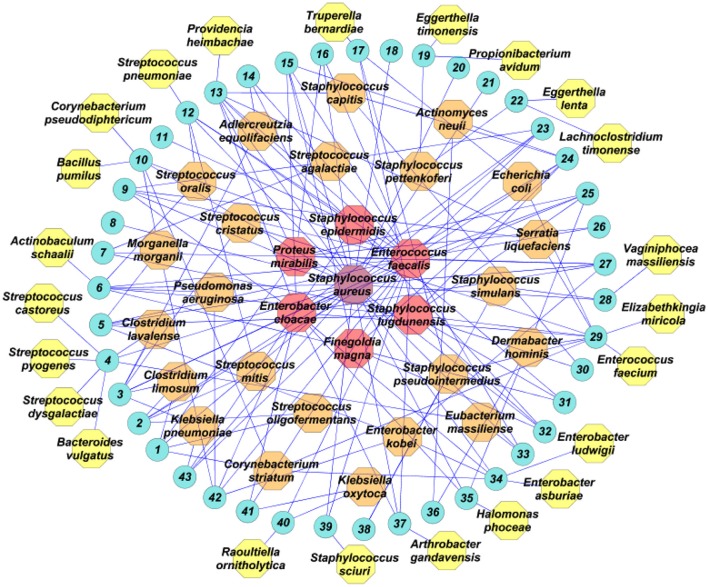
Bacterial species isolated from wound samples from 43 patients (blue circles), analyzed using culturomics. In purple, the most prevalent bacterial species; in red, the bacterial species isolated in five or more patients; in orange, the bacterial species isolated in more than one patient; in yellow, species isolated in only one patient.